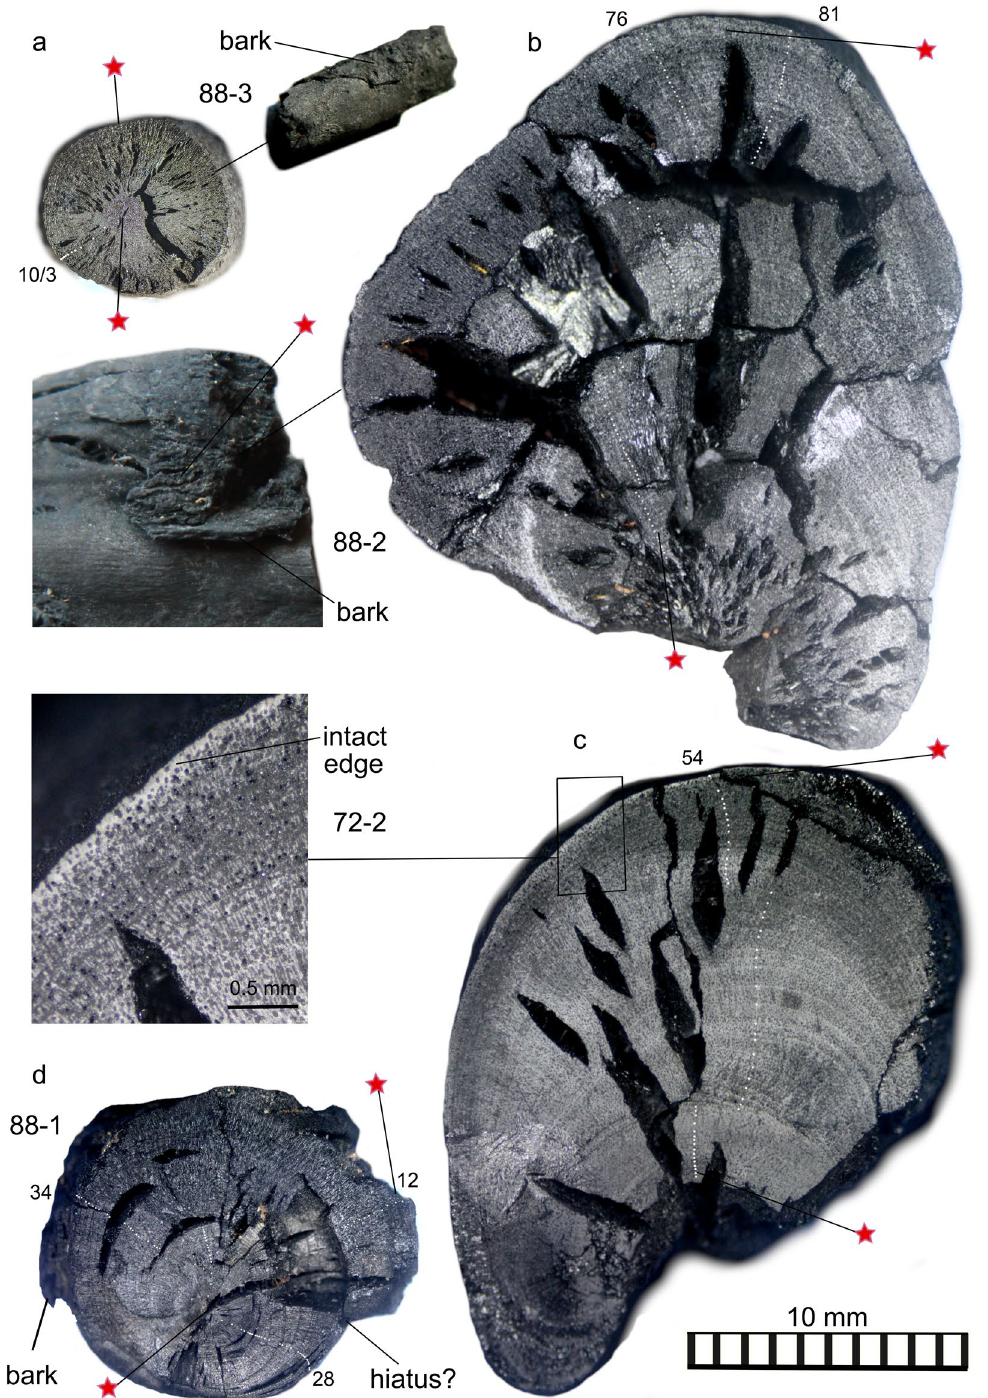
Figure 2. Enlarged photo-micrographs of sub-samples of the Therasia olive shrub showing approximate growth increment counts and inherent difficulties in interpreting growth patterns. Red stars show radiocarbon sampling locations. 88-3 and the bark of 88-2 produced the youngest radiocarbon dates from the shrub as a whole at the time of death. Image credit: